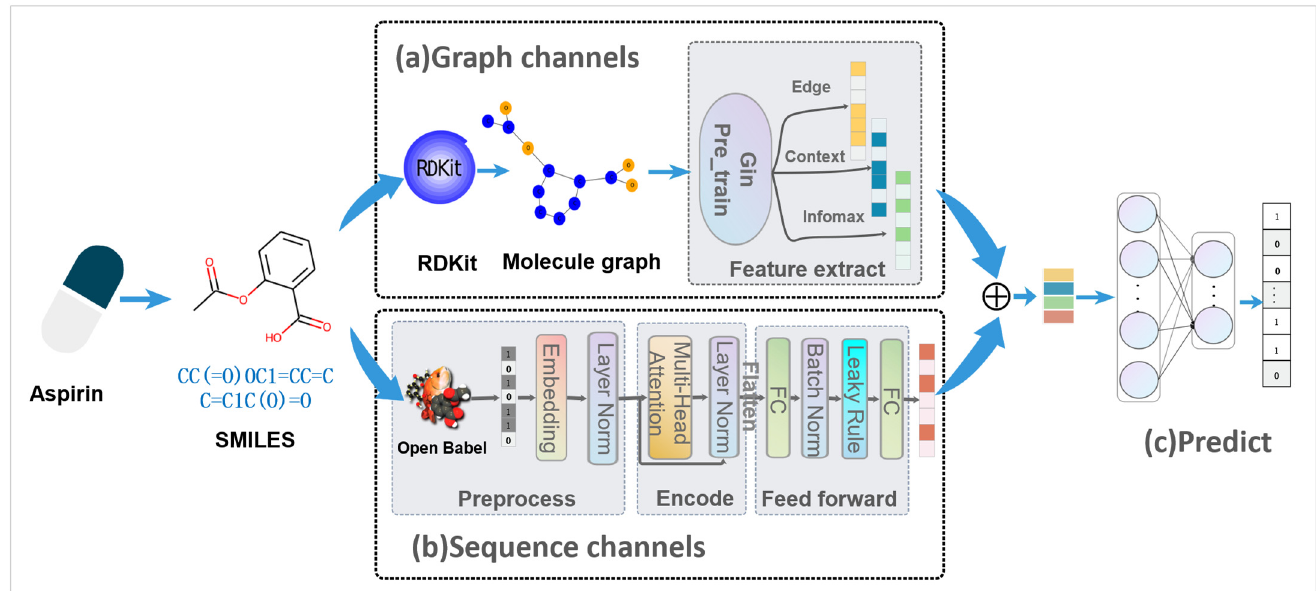
Figure 7. iADRGSE framework. ( a ) Graph channel. We perform the RDKit tool to convert the drug SMILES into chemical structure graphs and feed them into a pretrained GIN network ,to learn graph-based structural information. ( b ) Sequence channel. The preprocessing unit utilizes Open Babel software to generate molecular substructure sequences from the SMILES of drugs. Then, the substructure sequences are represented as one-dimensional sequence vectors through the embedding layer. Next, the correlation information of each substructure is extracted further, using the encoder unit with a multi-head self-attention mechanism. Finally, the feed-forward unit (a multi-fully connected layer) receives encoded data from the upper layer to obtain the final sequence-based structural information of drugs. ( c ) Prediction module. These two types of structural information are concatenated and then mapped to the size of the labels, through an affine transformation for multi-label prediction.